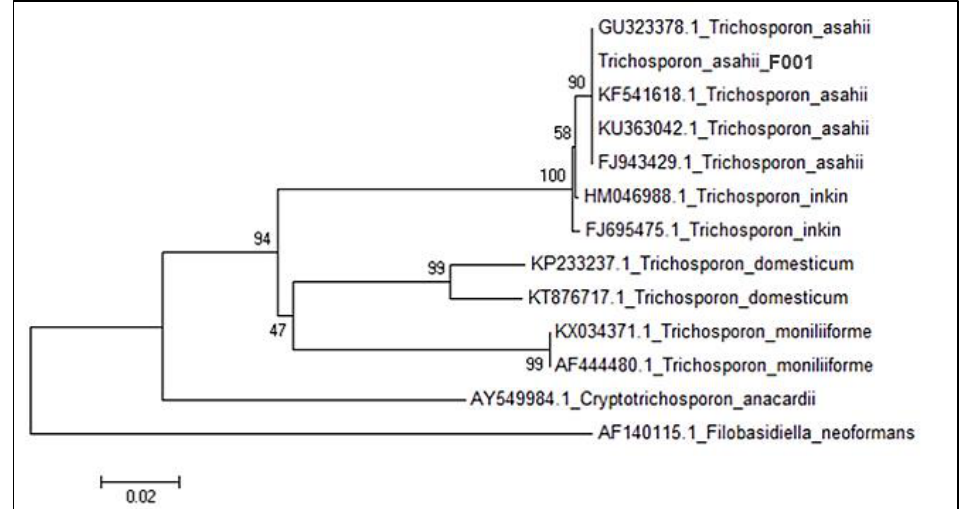
Figure 3. Phylogenetic tree based on ITS rDNA sequence of Trichosporon asahii F001 and reference sequences of Trichosporon with outgroup genus Cryptotrichosporon and Filobasidiella . Tree generated using Neighbour Joining analysis with 1000 bootstrap simulations. Numbers on the branches represent bootstrap values.